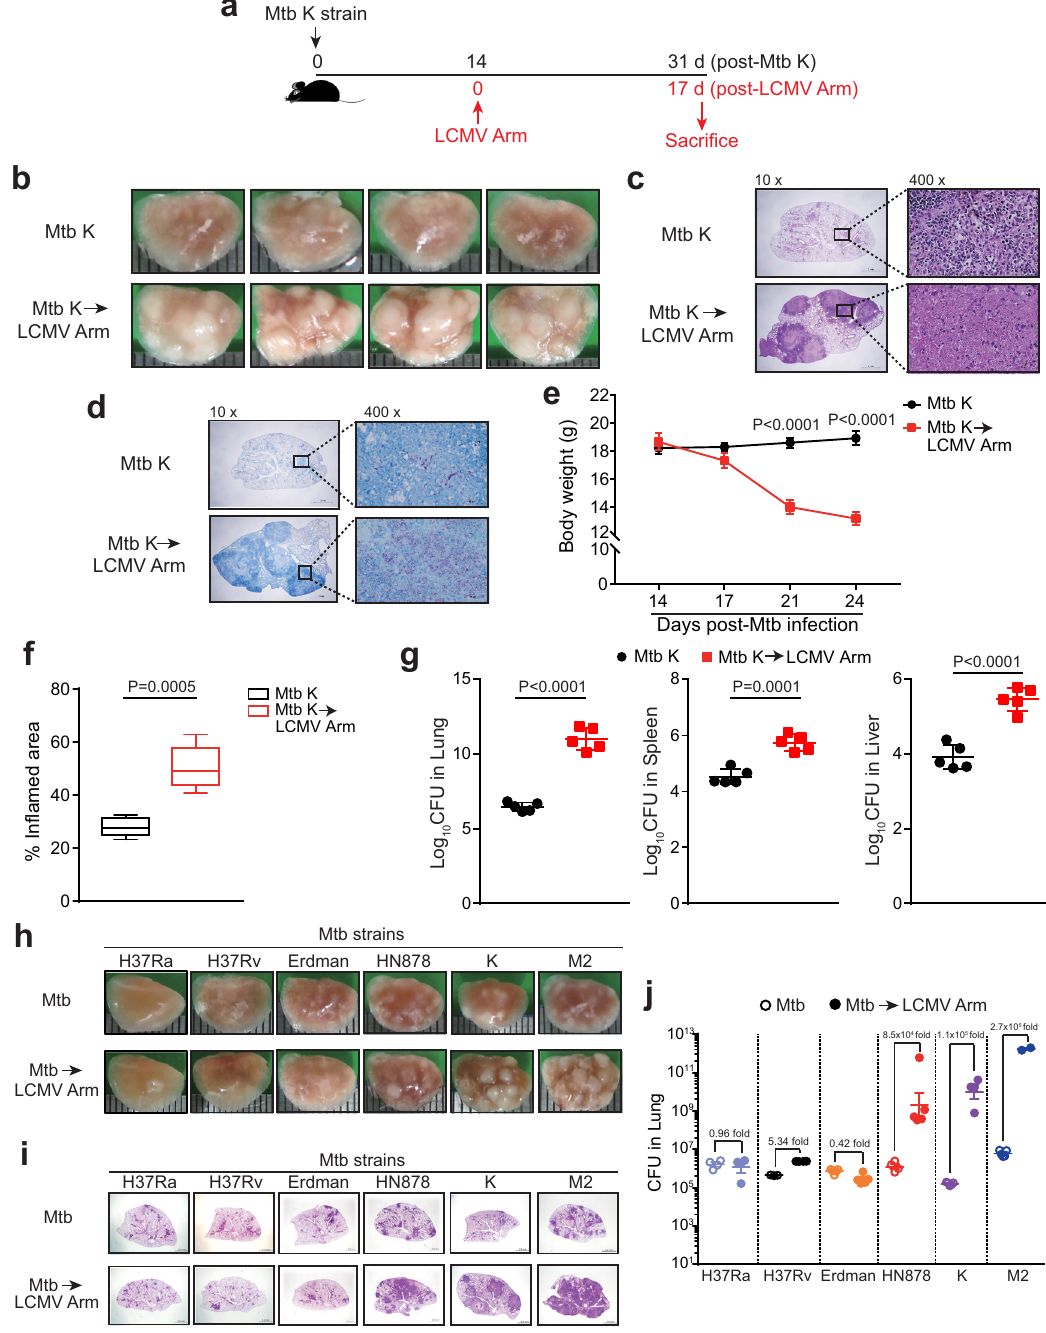
Fig. 1 Severe immunopathology with necrotic granulomas in Mtb K and LCMV Arm-coinfected mice and differential pathogenesis of coinfected mice depending on the Mtb strain. a C57BL/6 mice were infected with Mtb alone or with Mtb followed by subsequent infection with LCMV Arm at 14 days post Mtb infection. At 31 days post Mtb infection, the mice were sacri fi ced. b Gross pathology or c , H&E staining of lungs in each group. d Acid-fast staining of the lung in each group. (10x, scale bars, 2 mm; 400x, scale bars, 50 μ m). e The weight of mice at the indicated time points ( n = 4 or 5). f The data represent the percentage of the superior lobe of the right lung showing in fl ammation and are shown as center, bounds of box-and-whisker and percentile plots showing the minimum and maximum values ( n = 5). g , Bacterial load in the organs of each group ( n = 5). C57BL/6 mice were infected with the indicated Mtb strains. Some mice from each group were subsequently infected 2 weeks later with LCMV Arm. At 4.5 weeks post Mtb infection, the mice were sacri fi ced. h Gross pathology or i H&E staining of lungs in each group. Scale bars, 2 mm. j Bacterial load in the lungs of each group. Data were analyzed by e – g , two-tailed unpaired Student ’ s t test. Graphs show the mean ± SEM. b , c , d , f , g , The data are representative of at least two independent experiments or h – j , a single experiment. Source data are provided as a Source Data fi